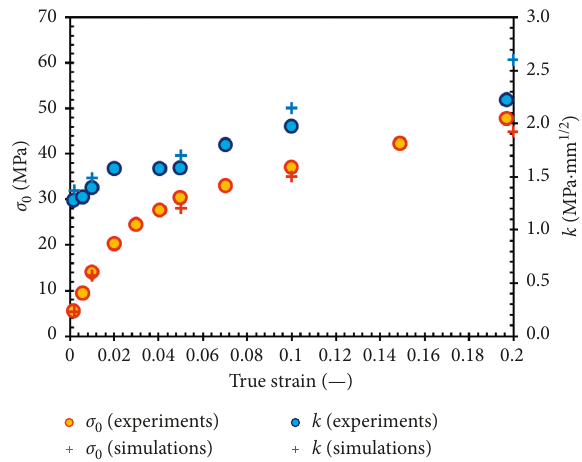
6: Hall–Petch constants as a function of strain for pure aluminium from experiments [25] and